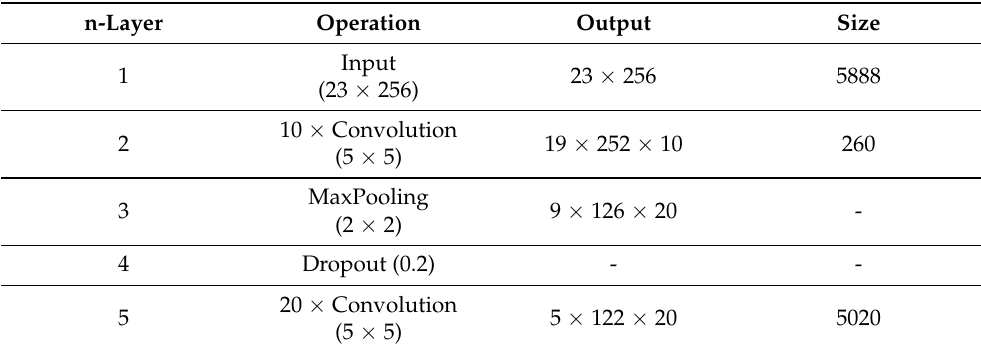
Table A2. Structural adaptation of the CNN for implementation on GAPuino Board using the GAP8 SDK and memory size per layer. In total the CNN has a number of 10.162 trainable parameters and a memory requirement of 62.7 kB for 32-bit